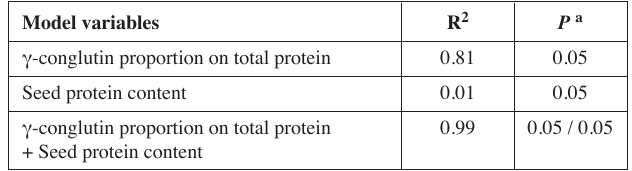
Tab. 3: Ability of simple and multiple linear regressions models to explain seed γ-conglutin content variation of five white lupin genotypes across two climatically-contrasting Italian environments as a func- tion of seed protein content and/or γ-conglutin proportion on total protein.